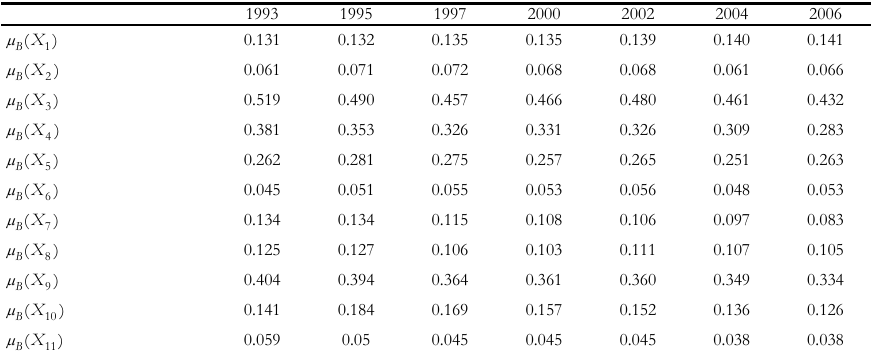
Unidimensional poverty